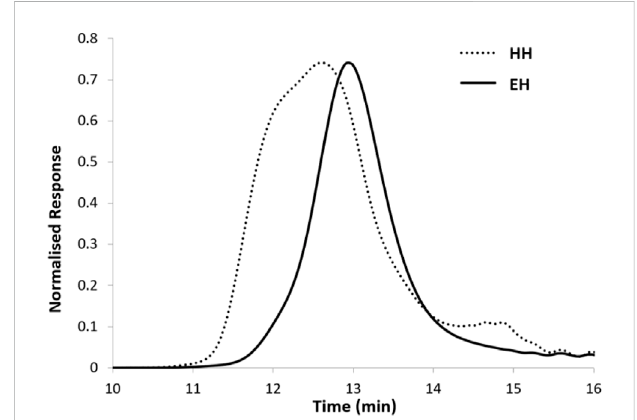
FIGURE 5 Comparison of the GPC trace of the product polymer synthesized withidenticalreactiontimeunderE- fi eld(solidline)andH- fi eld(dotline) heating at a power of 150 W. Condition [CL]:[FeCl 3 ] =